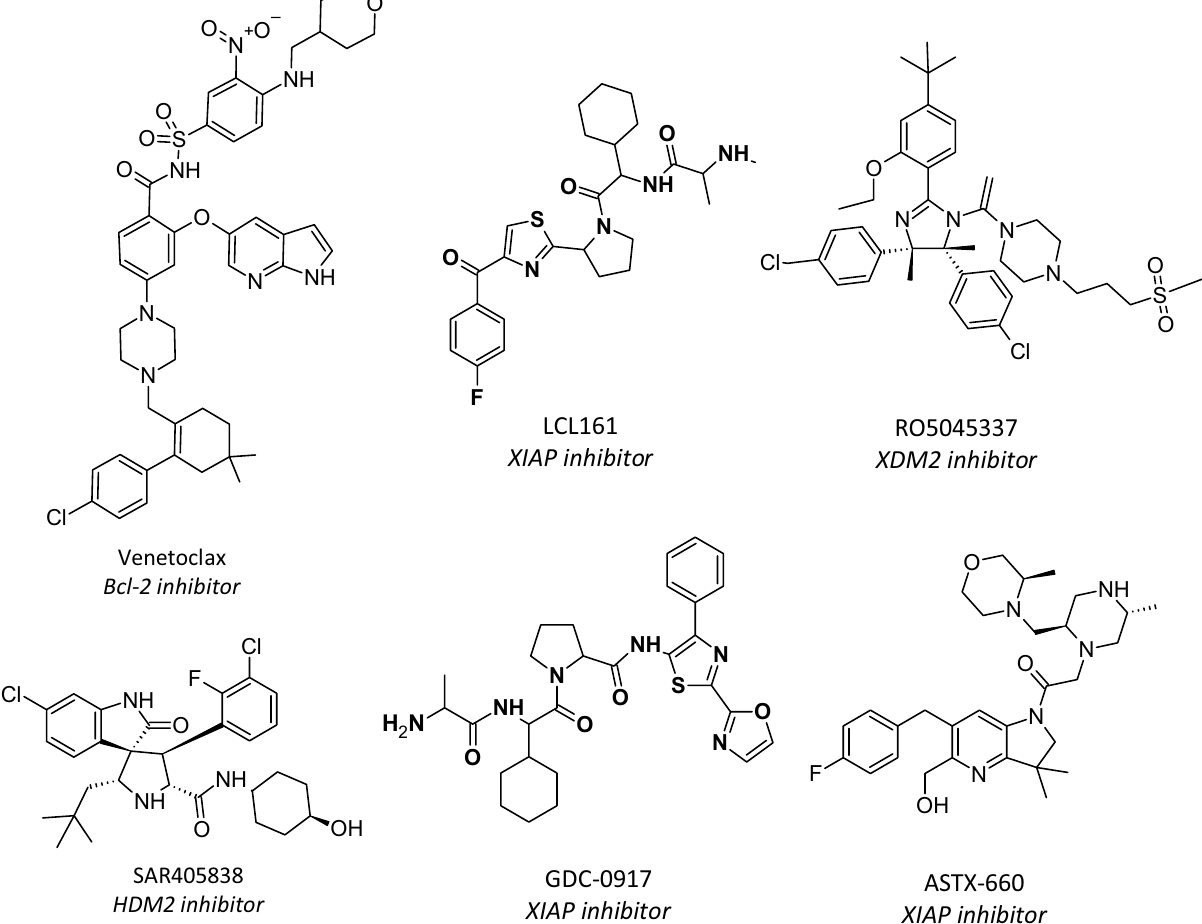
Figure 1. Examples of potent small molecule protein–protein interaction inhibitors that reached the clinical